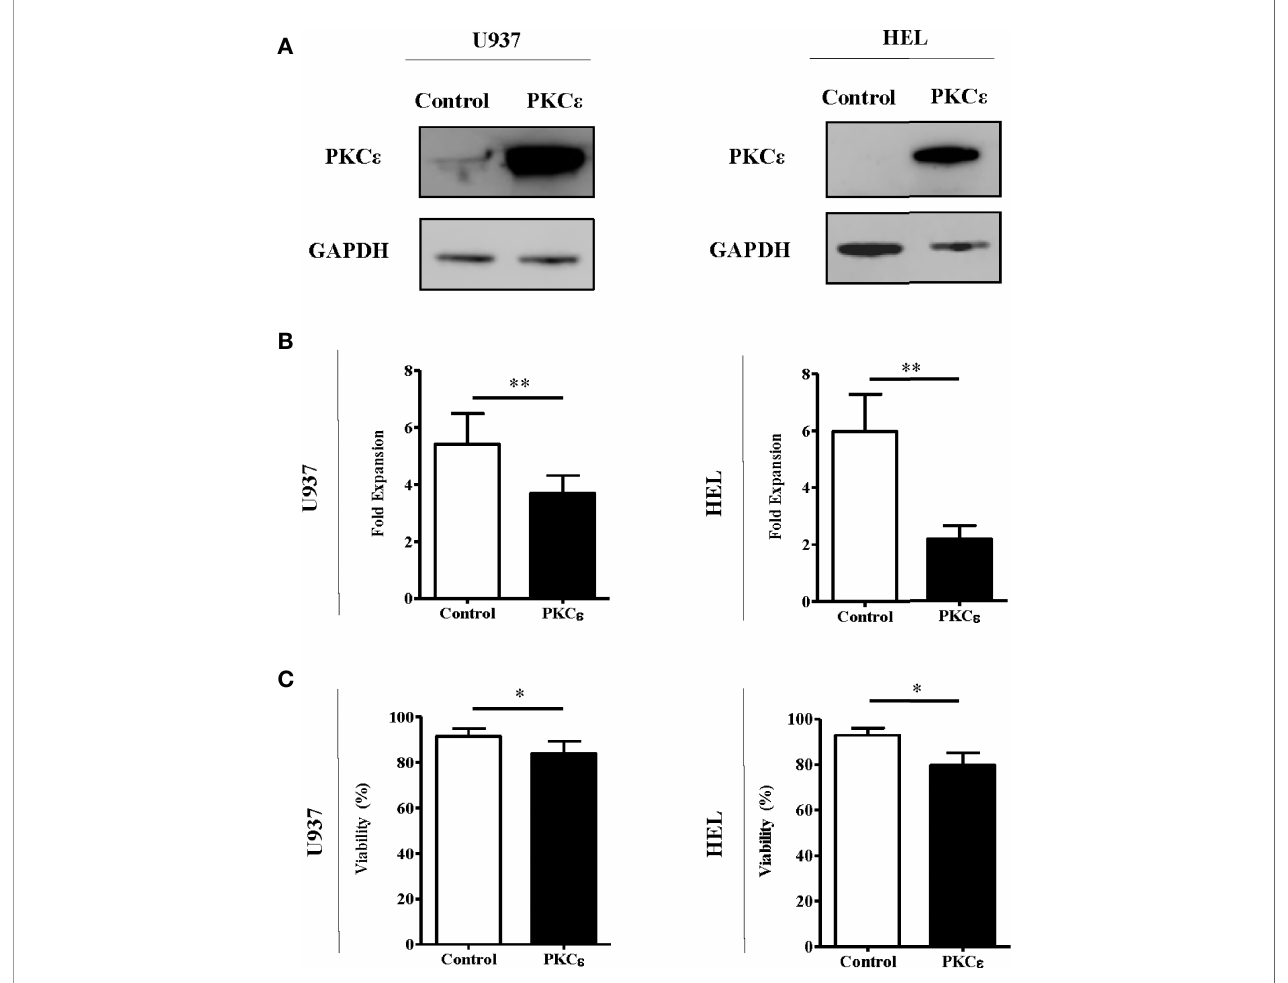
FIGURE 3 | PKC ϵ overexpression reduces the fold expansion of AML cell lines. (A) Representative western blots showing PKC ϵ (MW-84kDa) expression in U937 and HEL cells transduced with the control or PKC ϵ overexpression constructs. PKC ϵ expression is shown alongside GAPDH (MW-36kDa) expression which was used as a loading control; n=2. PKC ϵ expression was detected using the Cell Signaling Technologies antibody (22B10; Supplementary Table 2 ) while GAPDH was detected using the ThermoFisher Scienti fi c antibody (GA1R; Supplementary Table 2 ). (B) Fold expansion and (C) viability of U937 and HEL cells transduced with the control or PKC ϵ overexpression constructs 48 hours after seeding. Fold expansion and viability were determined using TOPRO-3 staining; n=4; *p < 0.05, **p < 0.01 using paired